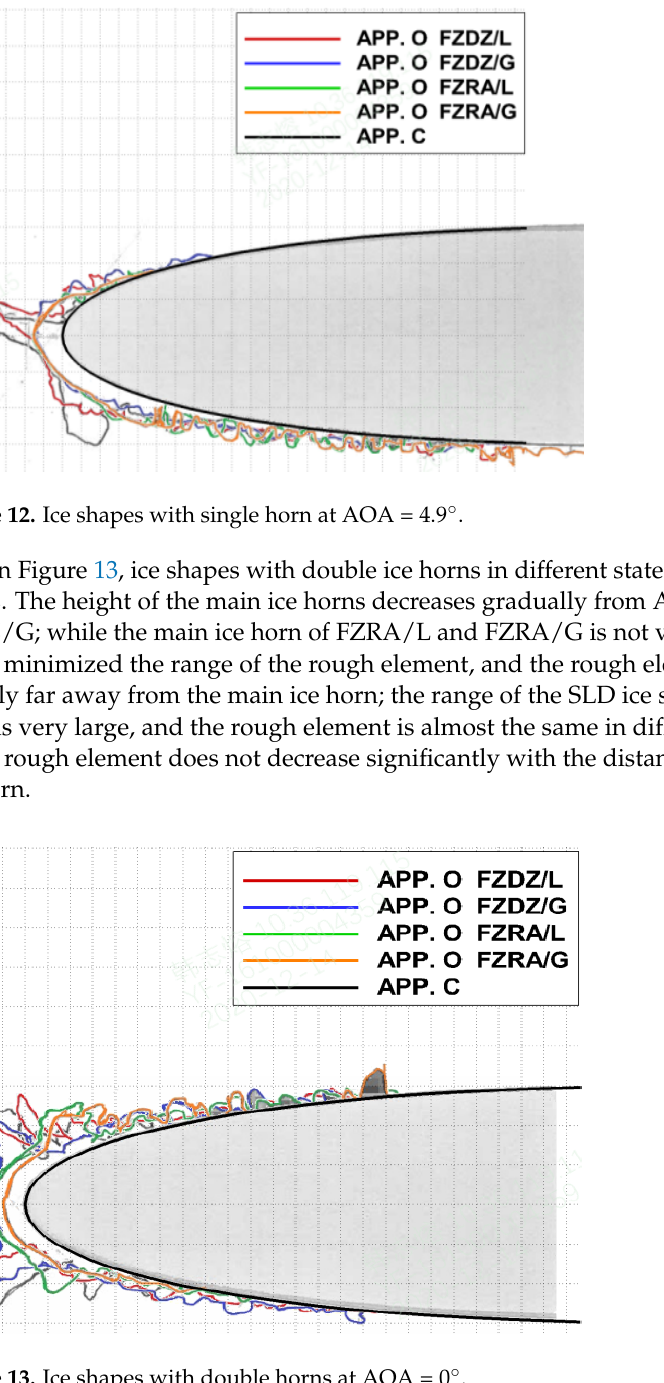
Figure 13. Ice shapes with double horns at AOA = 0°.